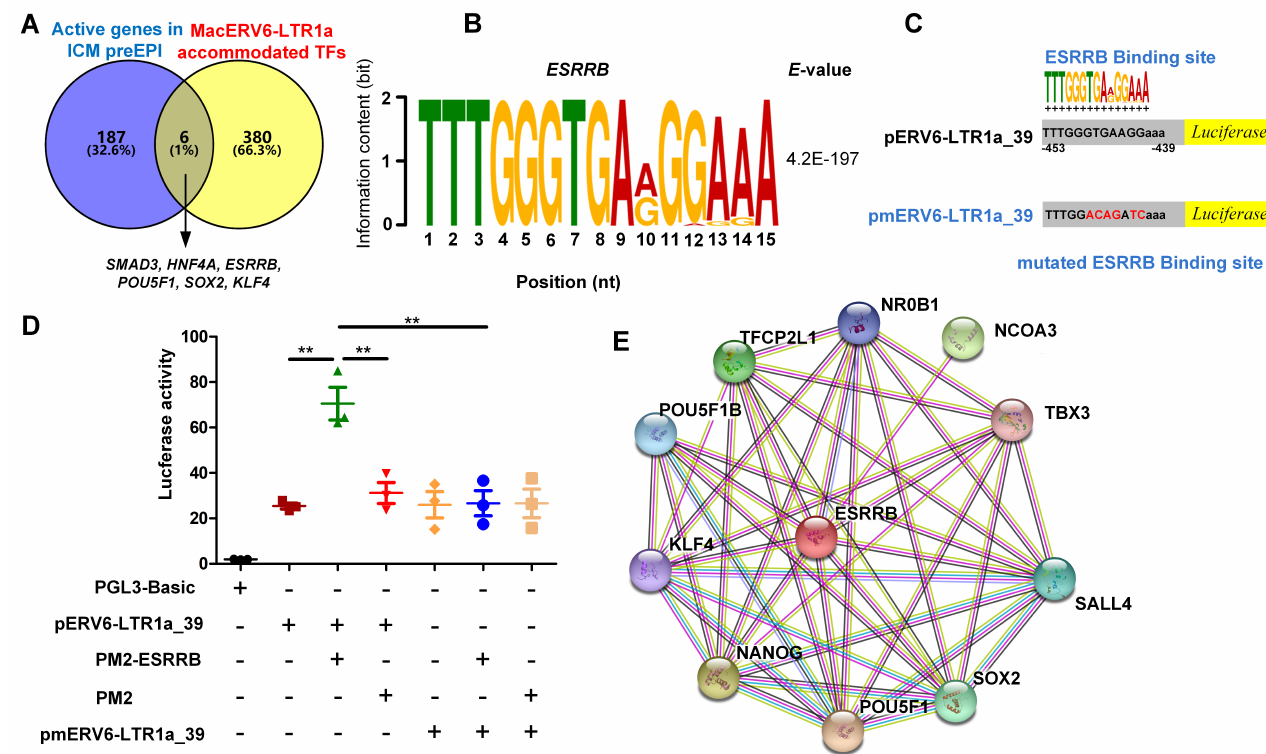
Figure 6. In vitro MacERV6-LTR1a interactions with pluripotency factors. ( A ) A Venn diagram showing overlapping transcription factors (TFs) specifically activated in ICM and pre-EPI cells and potentially recruited by MacERV6-LTR1a. Overall, 193 active genes in ICM and preEPI cells were reported in [52]. Additionally, 386 MacERV6-LTR1a accommodated TFs were predicted with MEME [60] and Tomtom [61]. ( B ) The motif of ESRRB in MacERV6-LTR1a and its E-value were predicted and calculated by MEME, respectively. The height of the nucleotide (Y-axis) is information content (in bit) and the X-axis is the position in the motif (nt). ( C ) ESRRB binding sites mutation in MacERV6-LTR1a.The MacERV6-LTR1a_39 element sequence that contained multiple pluripotency TF-binding sites have cloned into PGL3-basic vector and driven firefly luciferase activity (named pERV6-LTR1a_39). The nucleotide sequences of MacERV6-LTR1a_39, which the ESRRB binding site had mutated and cloned into the PGL3-basic vector (named pmERV6-LTR1a_39). ( D ) ESRRB interacting with MacERV6-LTR1a by luciferase assay in 293T cells. PM2-ESRRB, the PM2 vector containing coding sequence of ESRRB. pmERV6-LTR1a_39, pERV6-LTR1a_39, the plasmid contains luciferase reporter driven by ESRRB binding sites mutated MacERV6-LTR1a_39 and MacERV6-LTR1a_39, respectively. * p -value < 0.05 or ** p -value < 0.01. NS, not significant. Student’s t -test. ( E ) The protein–protein interaction network of ESRRB protein and others identified with the STRING web tool (https://string-db.org/, accessed on 28 September